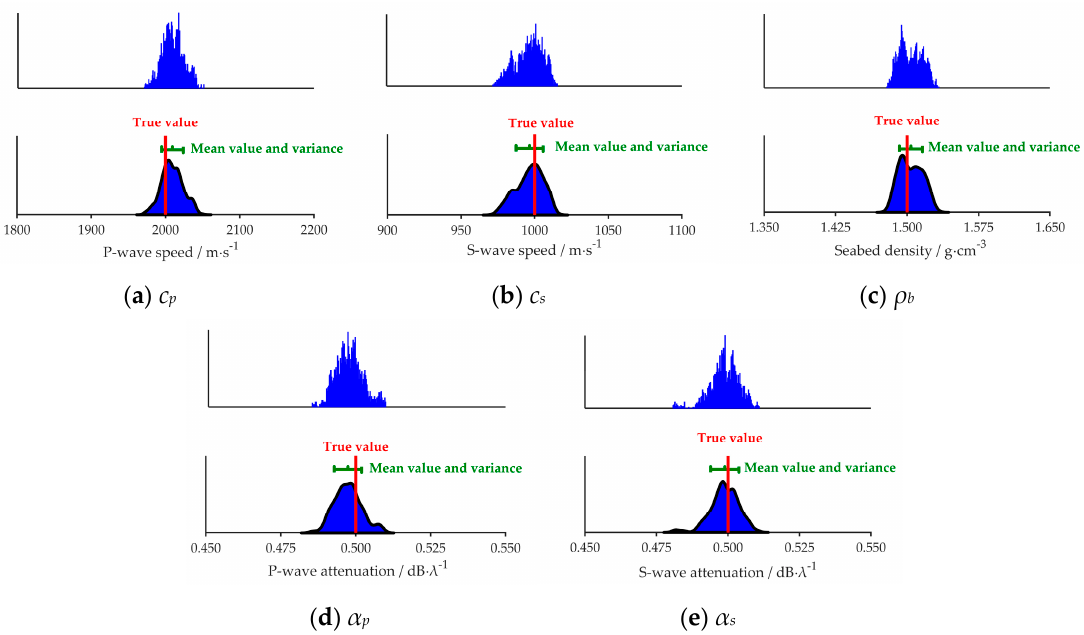
Figure 6. Five geo-acoustic parameters’ Posterior Probability Density (PPD) in the noiseless sea environment. The red lines mean the true value of each parameter in simulation. The green segments represent the mean value of the inversion results and their variance.